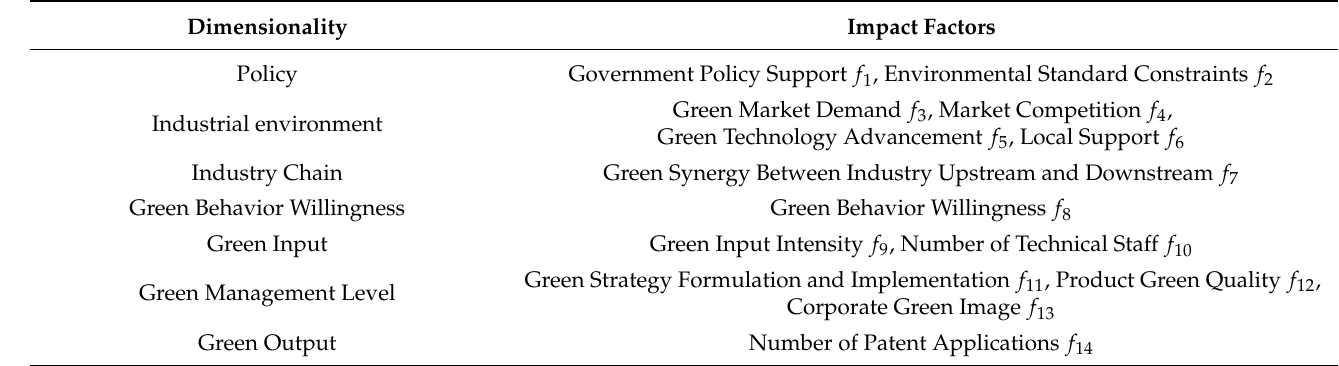
Table 2. The main factors impacting the green growth of wooden flooring manufacturing